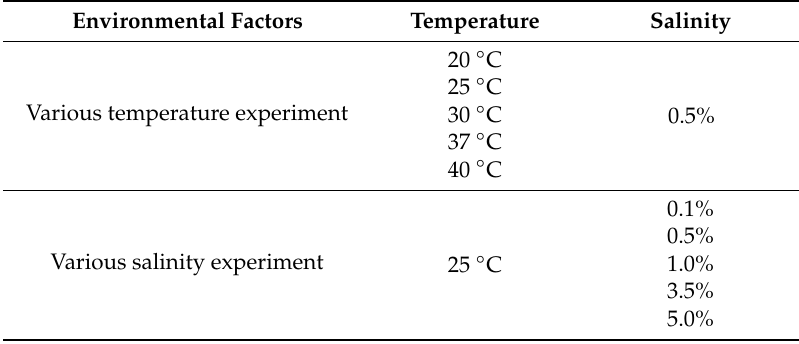
Table 1. Experimental set-ups for optimization of Mn(II)-oxidation by strain